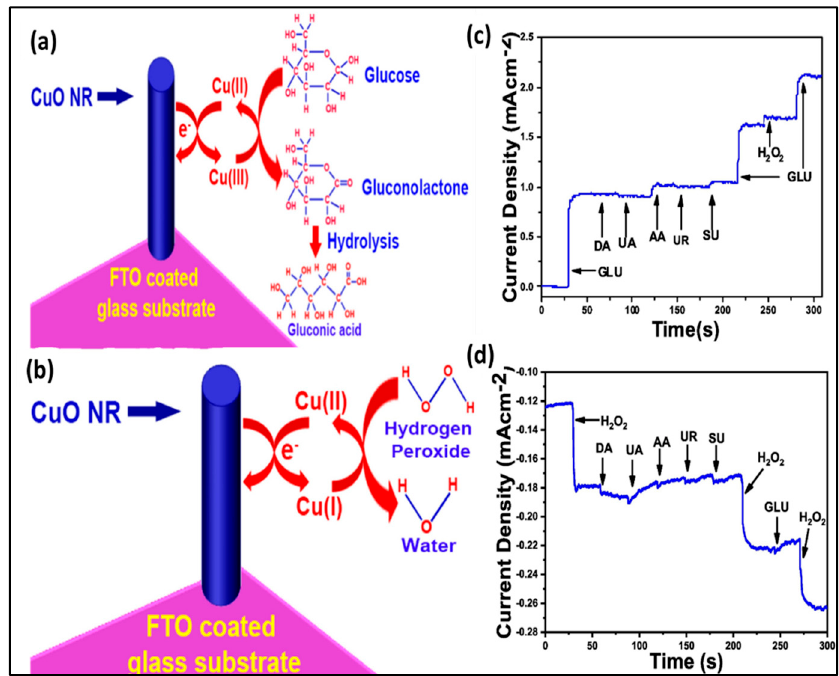
Figure 3. Schematic representation of CuO NRs: ( a ) glucose oxidation; ( b ) H 2 O 2 reduction; ( c ) interference study during glucose sensing after the addition of 0.1 mM of DA, UA, AA, UR and SU and 0.5 mM of H 2 O 2 along with 0.5 mM glucose; ( d ) interference during H 2 O 2 sensing during the addition of 0.1 mM DA, UA, AA, UR, SU and 0.5 mM of glucose along with 0.5 mM H 2 O 2 [66].